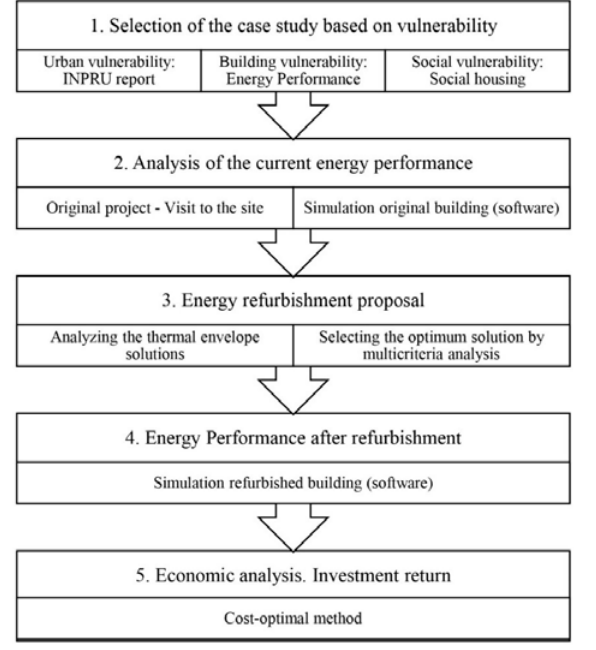
Figure 1. Methodology